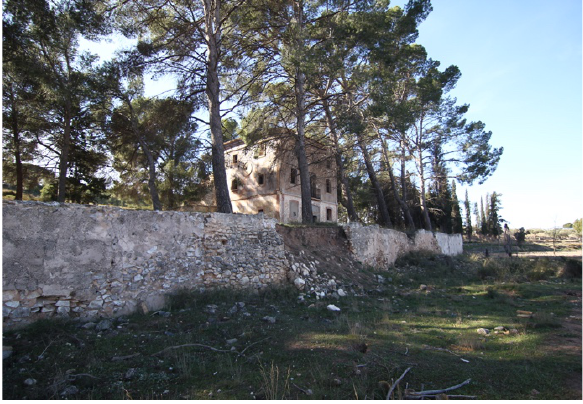
Figure 10. Current view of the garden.